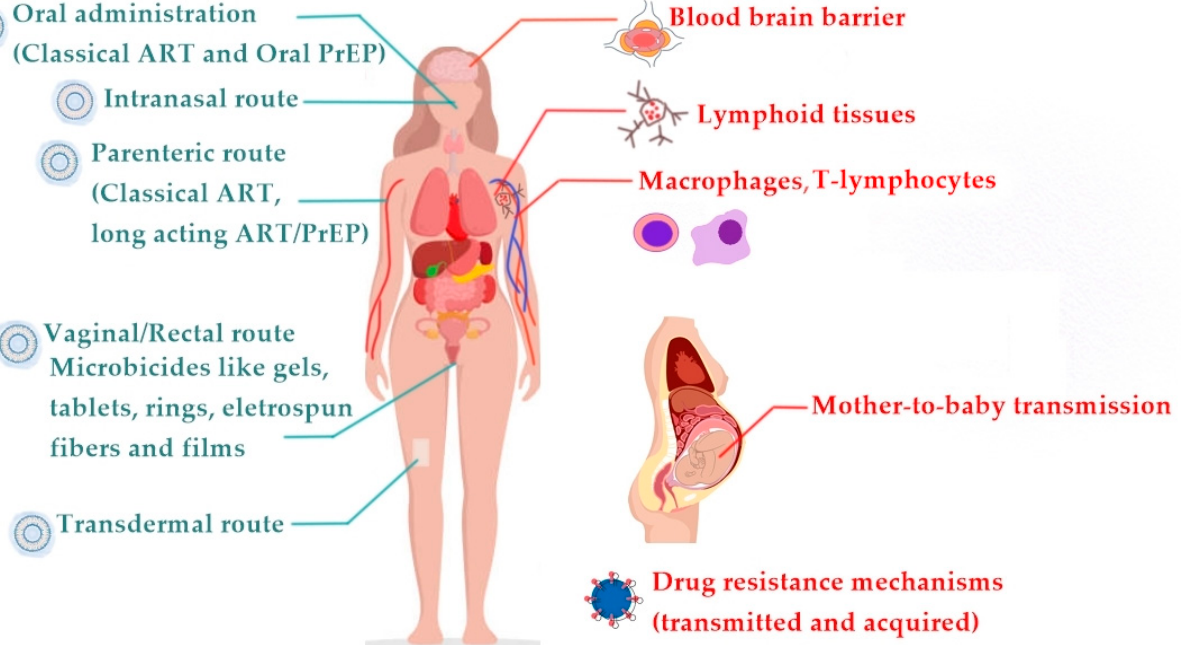
Figure 7. Potential ART (antiretroviral therapy) administration routes (left side in blue). The nanocarrier cartoon marks all possible routes of administration for lipid-based nanosystems. Classical ART formulations for therapy or pre-exposure prophylaxis (PrEP) are limited to oral and parenteral routes. Biological barriers to ART administration (right side in red).